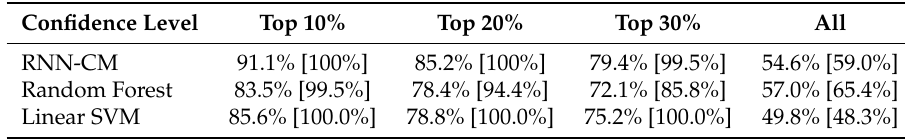
Table 1. The accuracy of classification based on the proposed representative segments (male segment fraction of all the high confidence segments) as determined by different algorithms on segments extracted from a trajectory using a T -hour ( T = 6) sliding